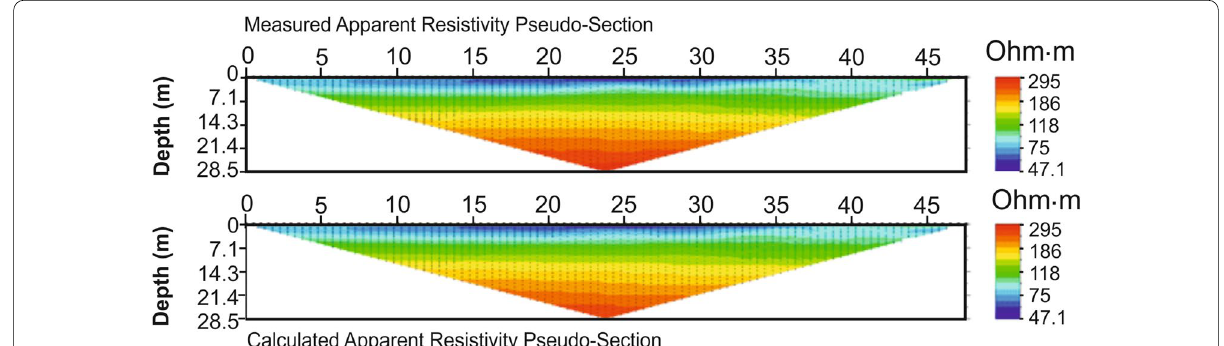
Fig. 5 An example of a pseudo-section of Line